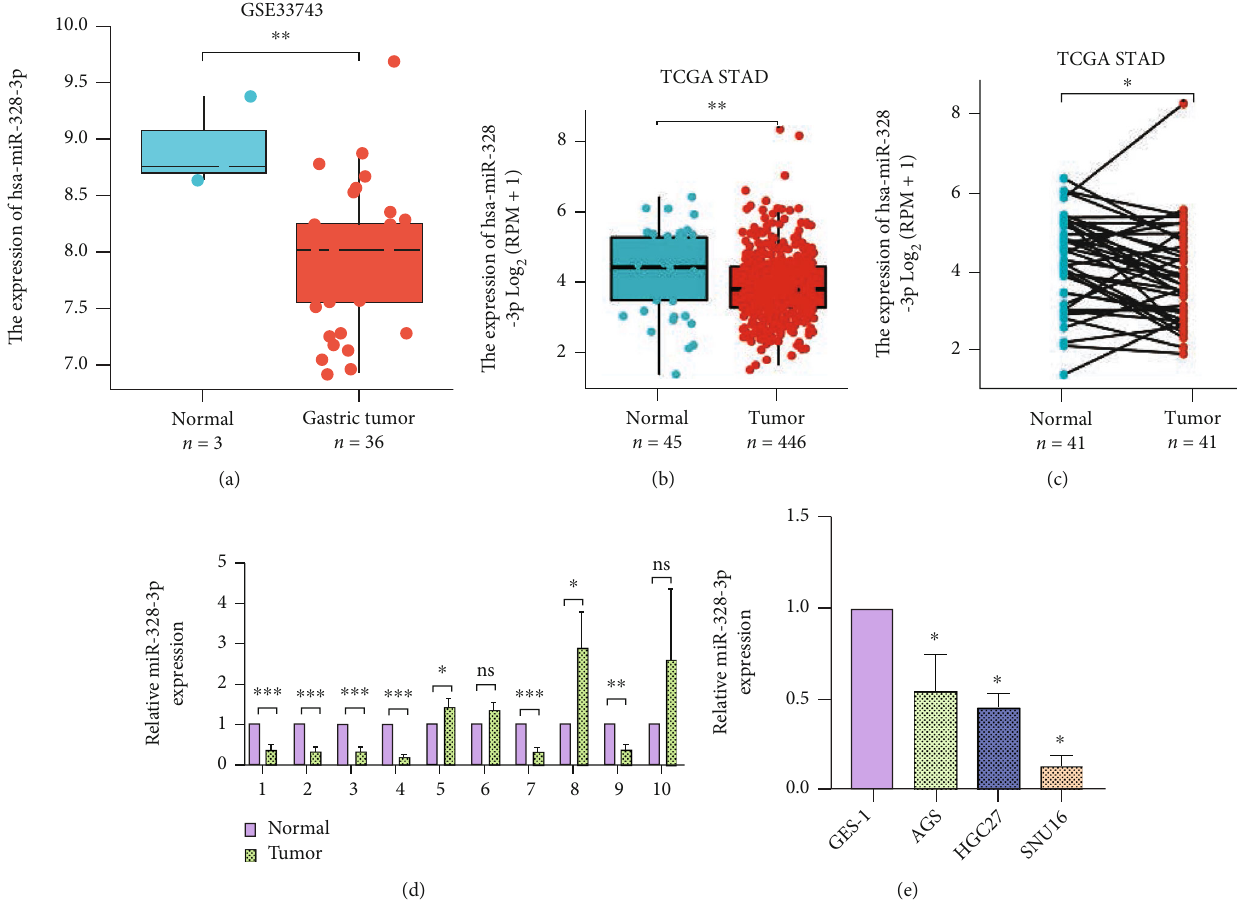
Figure 1: Low expression of miR-328-3p in STAD cells and tissues. (a) The expression pattern of miR-328-3p in GC via analyzing GSE33743 downloaded from NCBI GEO. (b, c) TCGA database was used to evaluate the expression level of miR-328-3p in (b) unpaired and (c) matched STAD samples. (d) qRT-PCR analysis of miR-328-3p expression in 10 pairs of clinical samples. (e) qRT-PCR was used to detect the expression level of miR-328-3p in STAD cells (AGS, HGC27, and SNU16) and in normal cells GES-1. All experiments were performed in triplicate. ∗ P < 0 : 05 , ∗∗ P < 0 : 01 , and ∗∗∗ P < 0 : 001